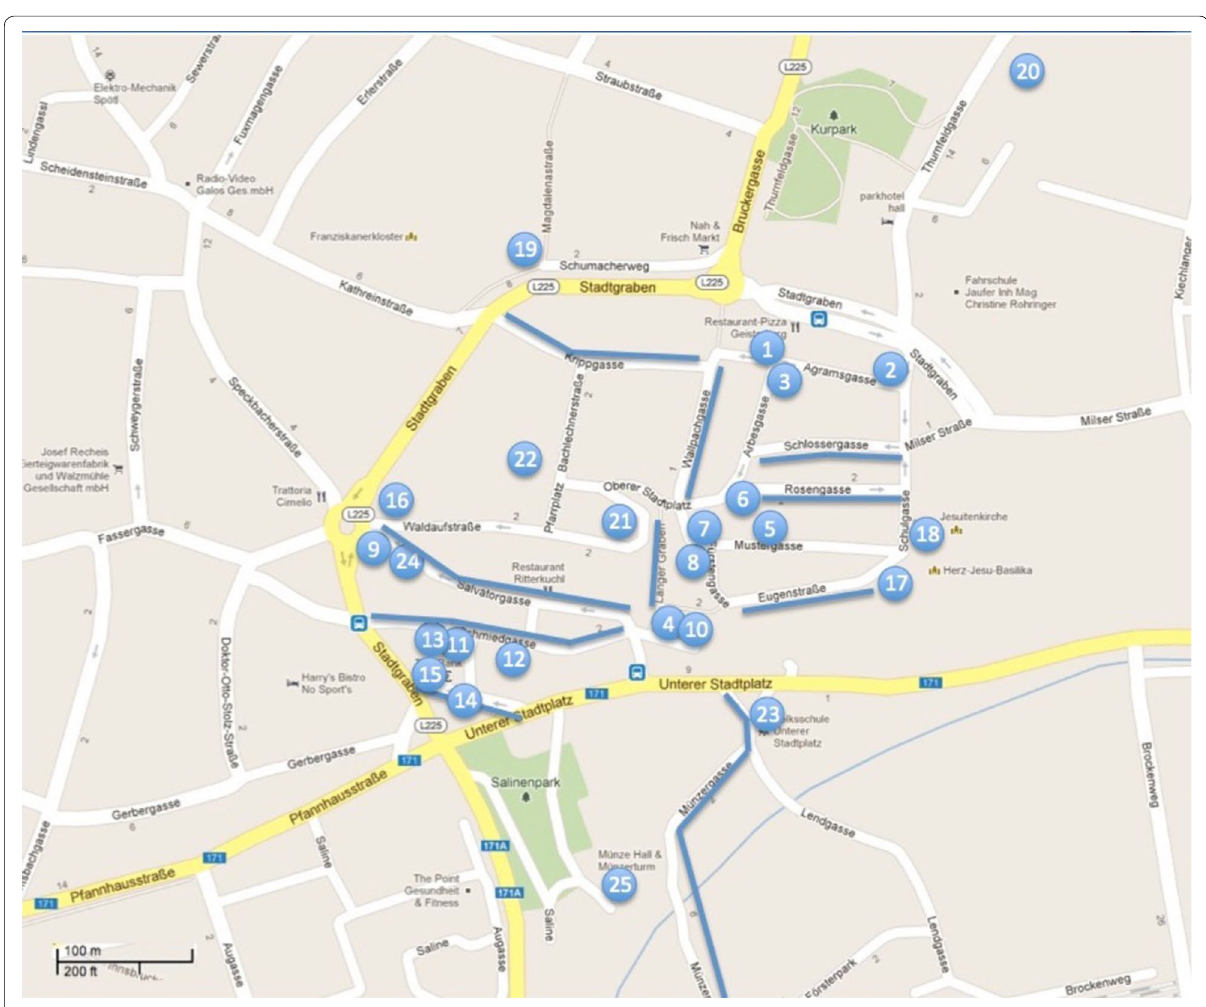
Fig. 3 Damage in Hall in Tirol caused by the earthquake of 17th July 1670. Blue lines mean that damage in the respective street was reported, but the damage could not be assigned to an address. 1 Agramsgasse Nr.5, 2 Agramsgasse Nr.23, 3 Arbesgasse Nr.6, 4 Langer Graben Nr.2, 5